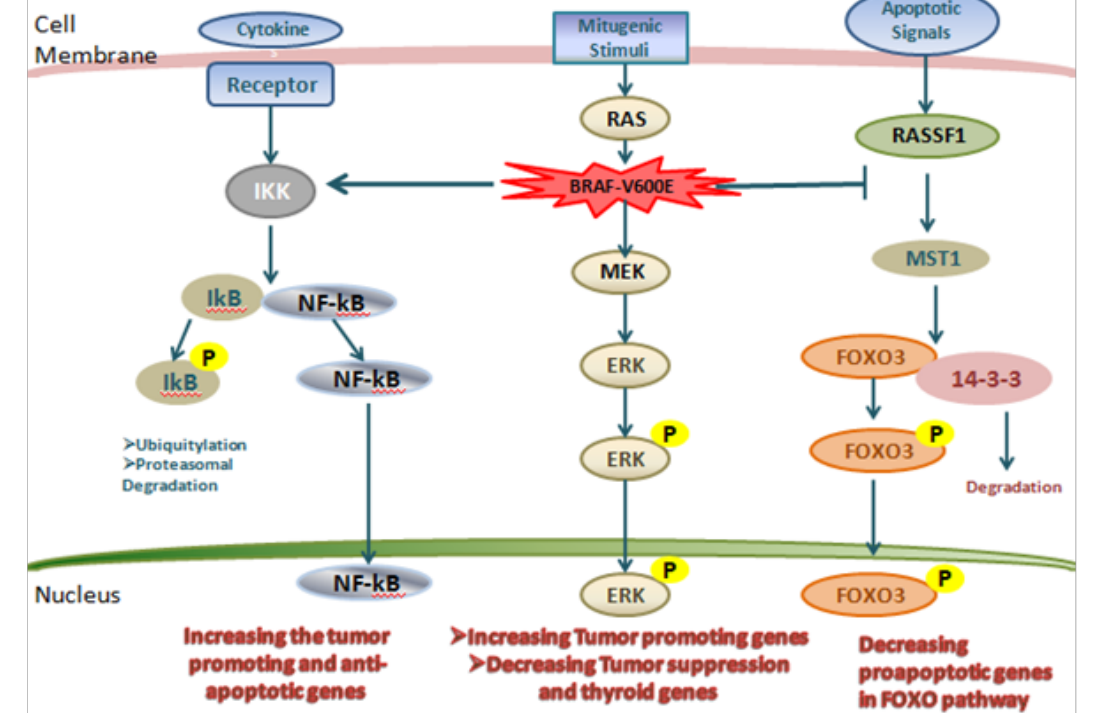
Figure 2. The MAPK and related pathways in thyroid